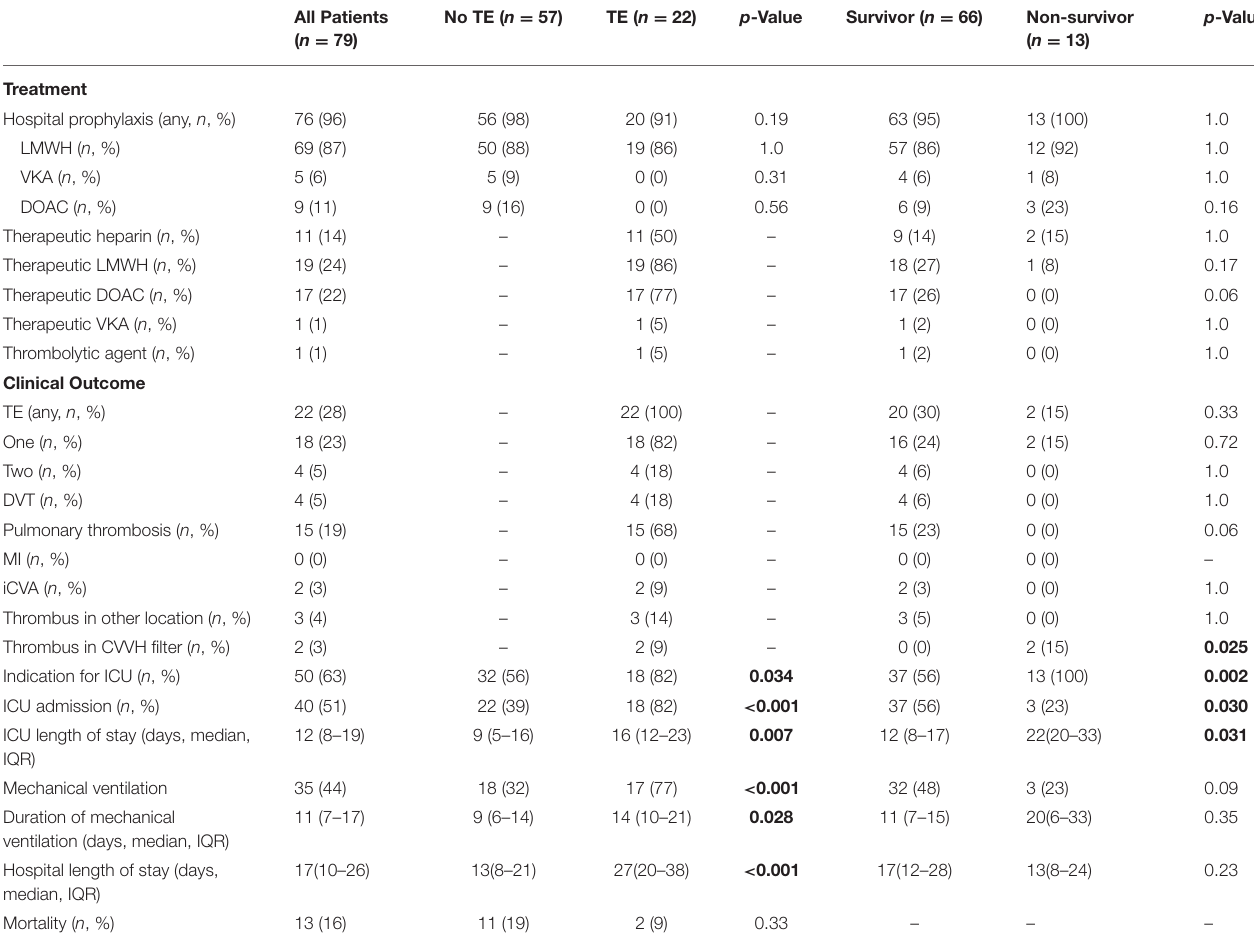
TABLE 2 | Patient treatment and clinical outcomes.